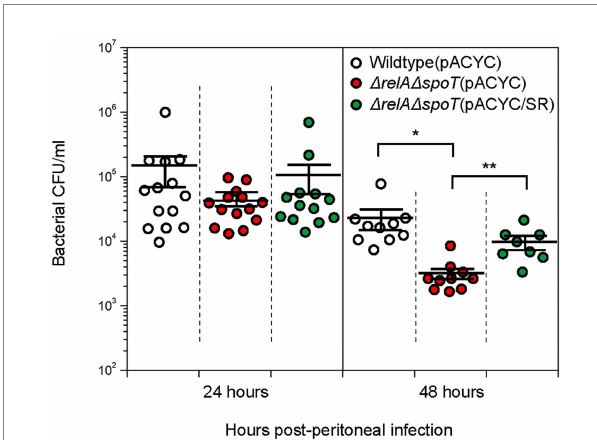
FIGURE 8 Improved bacterial clearance in C57BL/6 mice infected with Δ relA Δ spoT EPEC. C57BL/6 mice were challenged with wildtype (white), Δ relA Δ spoT mutant (red), or relA- and spoT -complemented mutant strain (green) via peritoneal injection. Bacterial colony forming units in peritoneal lavage fluids collected from C57BL/6 mice at 24 and 48 h post infection were counted by plating on Luria- Bertani agar plates supplemented with 5 μ g/mL tetracycline. Circles represent individual mice. Horizontal bars represent means ± standard errors of means. Statistical significance was obtained by Student’s t -test (* p < 0.05; ** p < 0.01). Wildtype (pACYC), E2348/69 strain carrying pACYC184; Δ relA Δ spoT (pACYC),